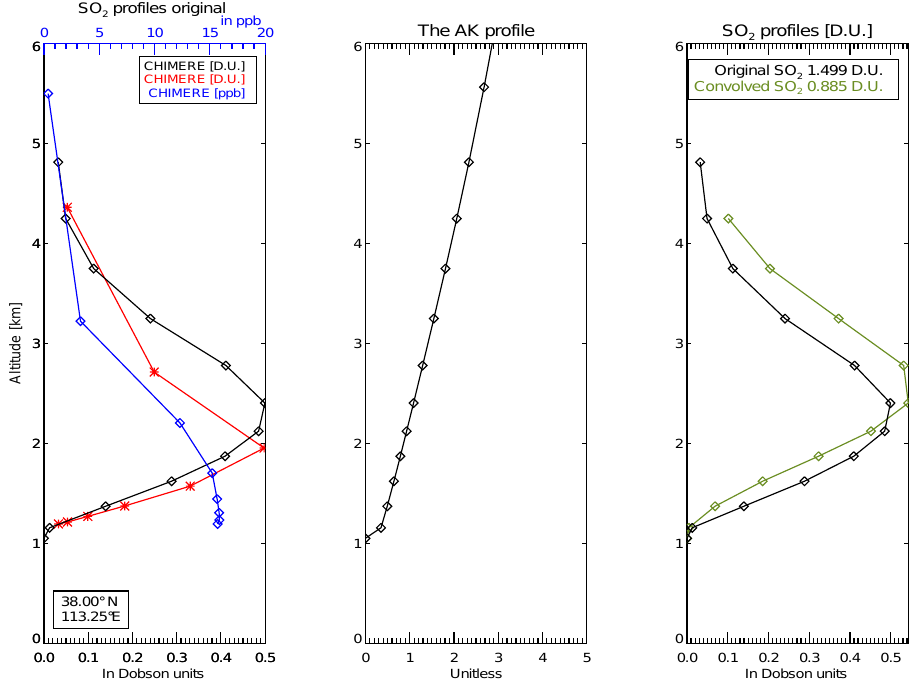
Figure 4. An example of the convolution of the CHIMERE SO 2 profile with the OMI averaging kernel to produce the convolved CHIMERE total SO 2 column for the grid of 38.0 ◦ N, 113.25 ◦ E. (a) The original CHIMERE SO 2 profile of eight levels in ppb is shown in blue; the same profile but in Dobson units per layer is given in red, whereas the profile in D.U. but of 58 OMI AK levels is given in black. (b) The OMI AK profile. (c) The original CHIMERE profile in D.U. per layer is shown in black, as in (a) , and the convolved CHIMERE profile in D.U. per layer is shown in olive green. The original CHIMERE total SO 2 column is 1.50D.U., whereas after convolution with the OMI AK it decreases to